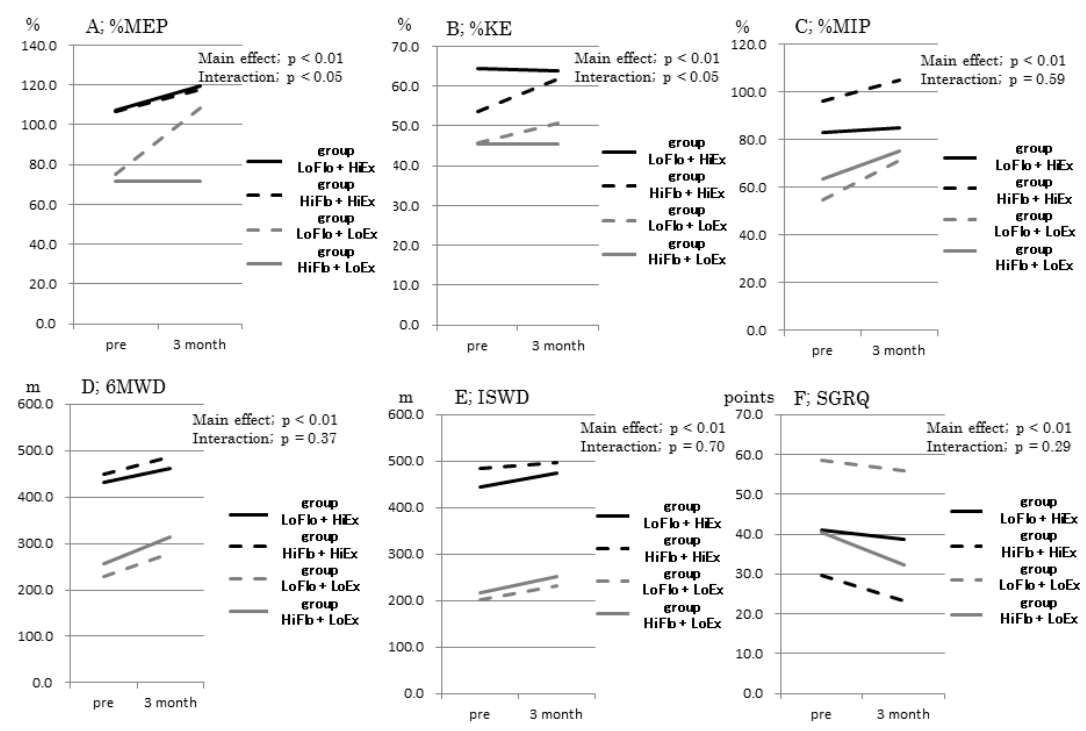
Figure 3. Comparison of the pulmonary rehabilitation effect for three months between each group. %KE, ratio of knee extension strength to body weight; %MEP, ratio of maximal expiratory pressure to body weight; %MIP, ratio of maximal inspiratory pressure to body weight; 6MWD, six-minute walking distance; ISWD, incremental shuttle walking distance; SGRQ, St. George’s Respiratory Questionnaire.